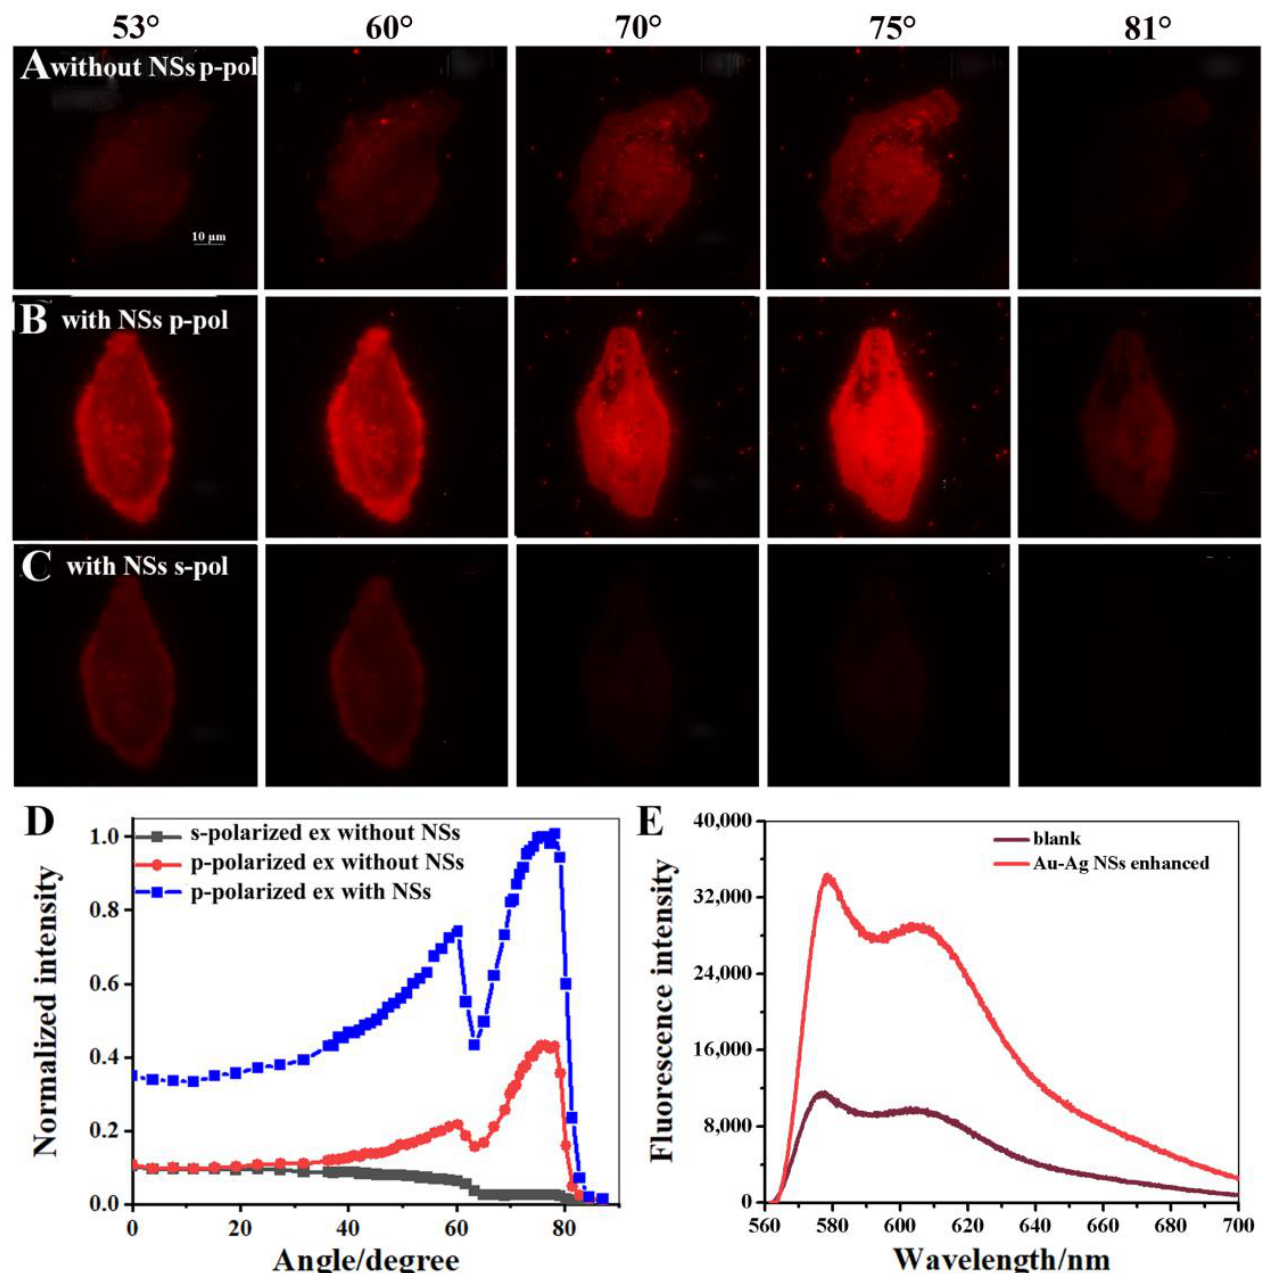
Figure 5. ( A ) The images of DiI-dyed cells at different excitation angles without Au-Ag NS modified on Au substrate. The images of DiI-dyed cells at different angles of excitation with ( B ) p-polarization and ( C ) s-polarization of the Au-Ag NS enhancement system. ( D ) The relationship between the normalized intensity of DiI-dyed cell images and excitation angle. ( E ) The fluorescence spectra of the DiI-dyed cells by SPR excitation with and without Au-Ag NS enhancement.